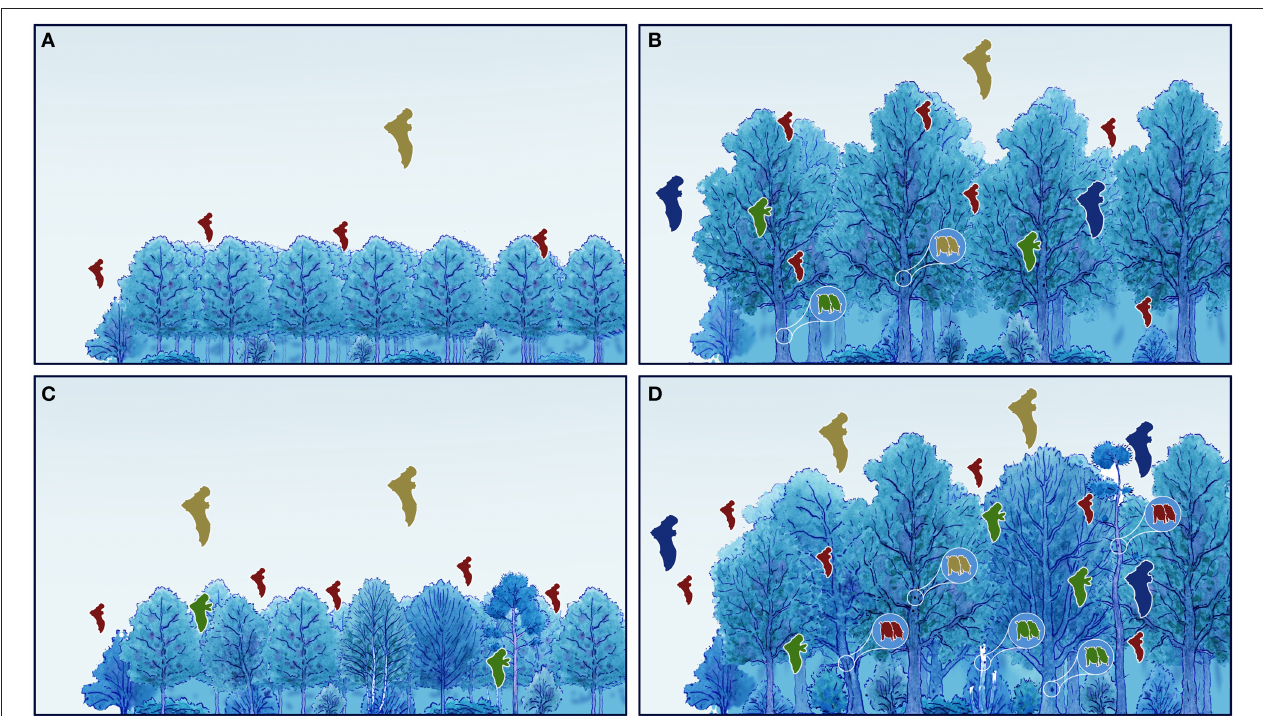
FIGURE 1 | Schematic illustration of the effects of forest age and structural variation (both profoundly influenced by the type of management applied) on the value of forest for bats. The latter increases both for feeding and roosting with increasing age and structural variation. (A) Young, structurally homogeneous forest; (B) Old, structurally homogeneous forest; (C) Young heterogeneous forest; (D) Old heterogeneous forest. Flying bats represent foraging, bats in circles represent roosting. The colors represent different guilds (brown, aerial hawkers, e.g., Nyctalus spp.; green, gleaners, e.g., Plecotus auritus ; red, small-size edge foragers, e.g., Pipistrellus spp.; blue, large-size edge foragers, e.g., Eptesicus serotinus